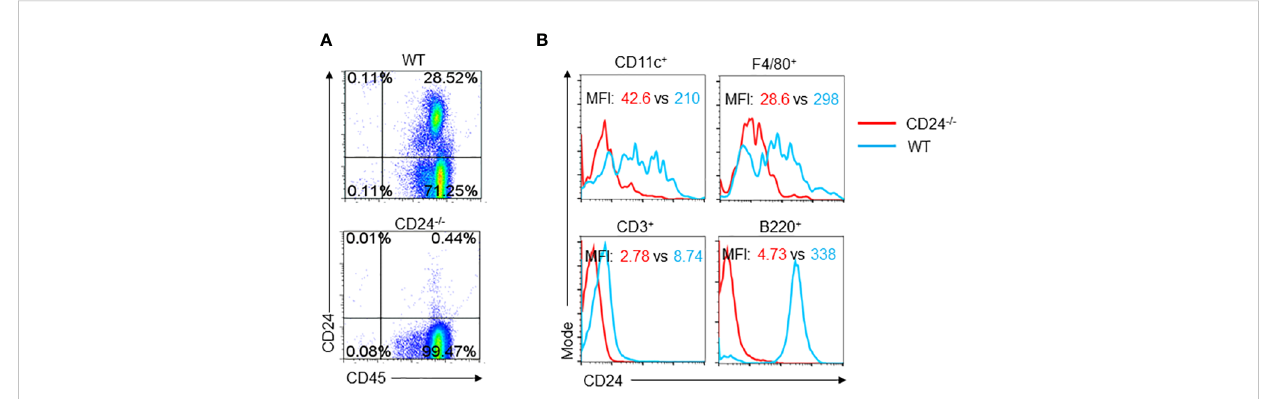
FIGURE 6 Expression of CD24 in lymph node cells. (A) . Lymph node cells from WT and CD24 -/- mice were stained for CD45 and CD24. (B) . CD24 expression on different subsets of CD45 + Cells. Lymph node cells from WT and CD24 -/- mice were stained for CD45, CD24 and one of the subset markers. Data represent fi ve experiments with similar results.